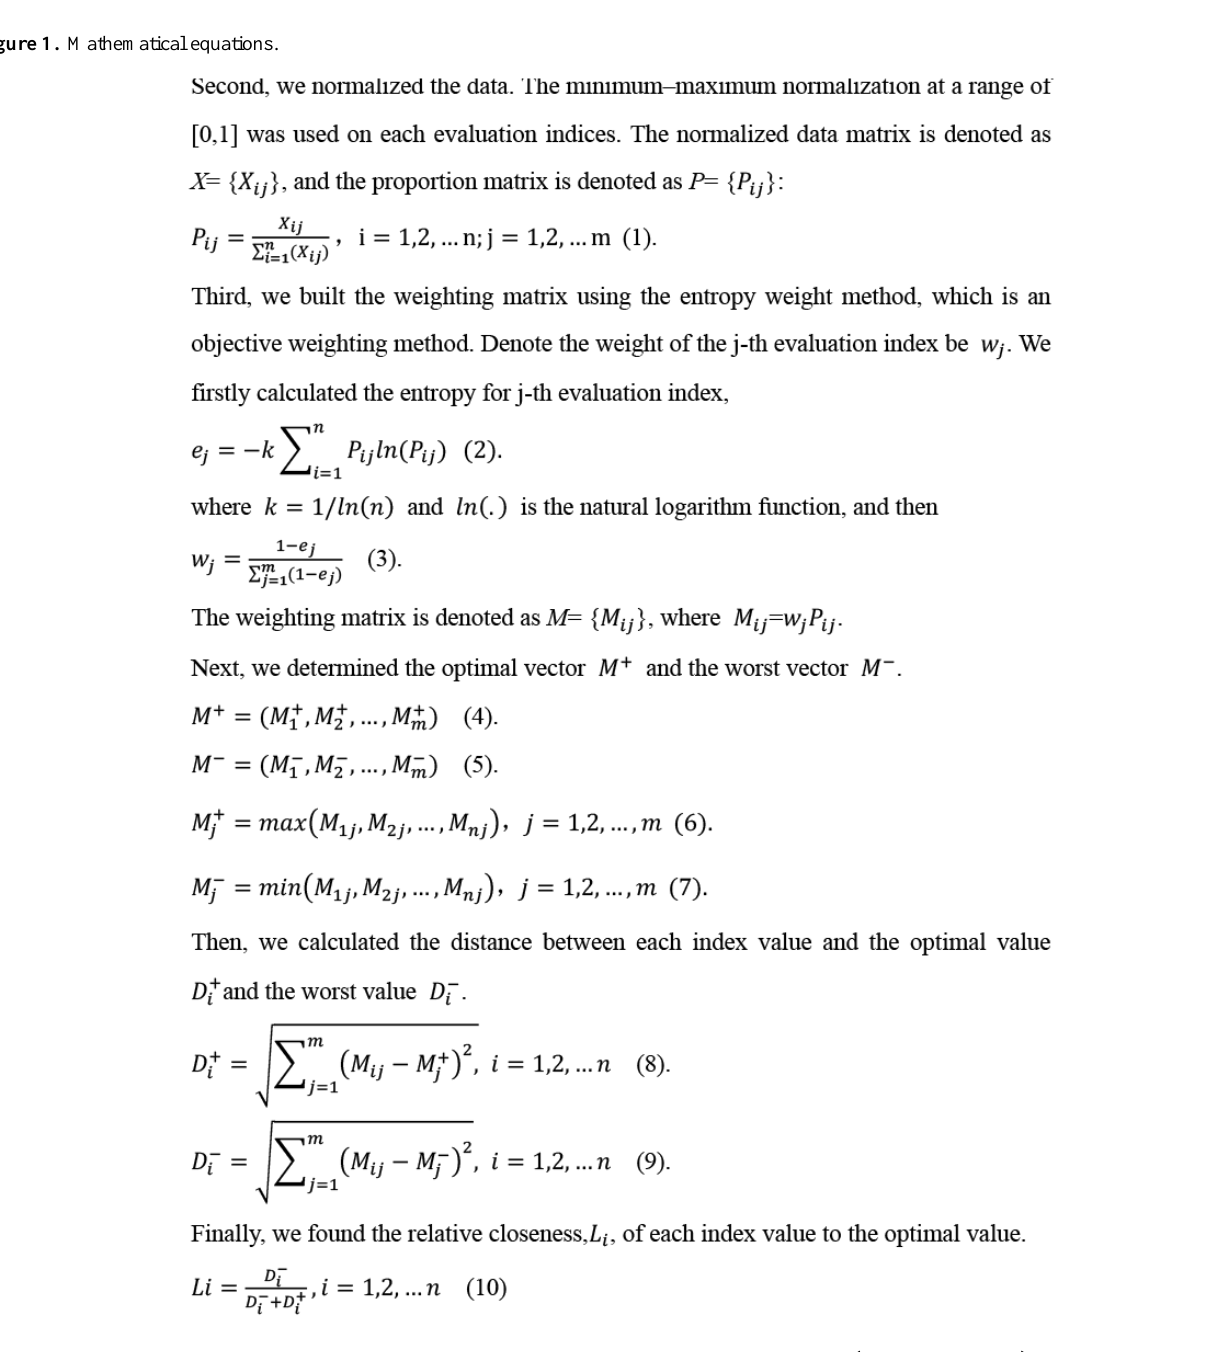
Figure 1. Mathematical